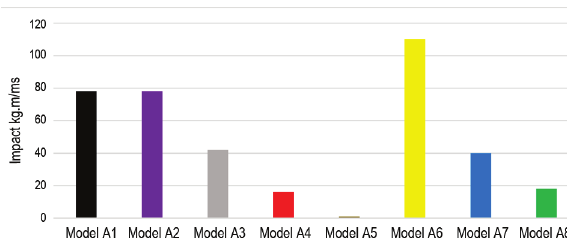
Fig. 9. Comparison chart of occurred impact on eight laminated glass